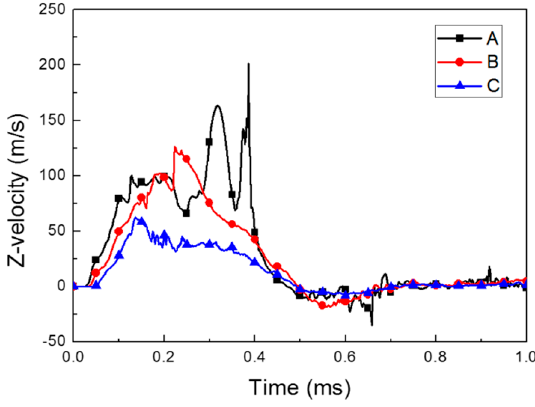
Figure 7. Forming velocity of the deformed sheet metal.